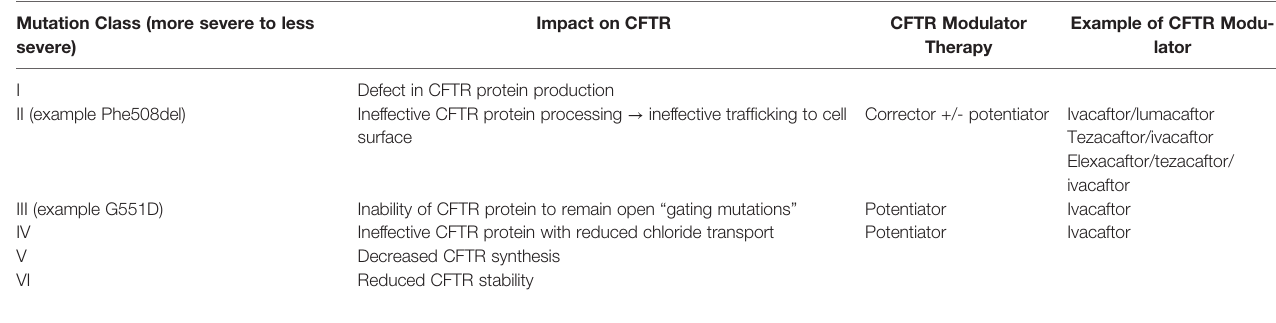
TABLE 3 | CFTR Mutations and Modulator